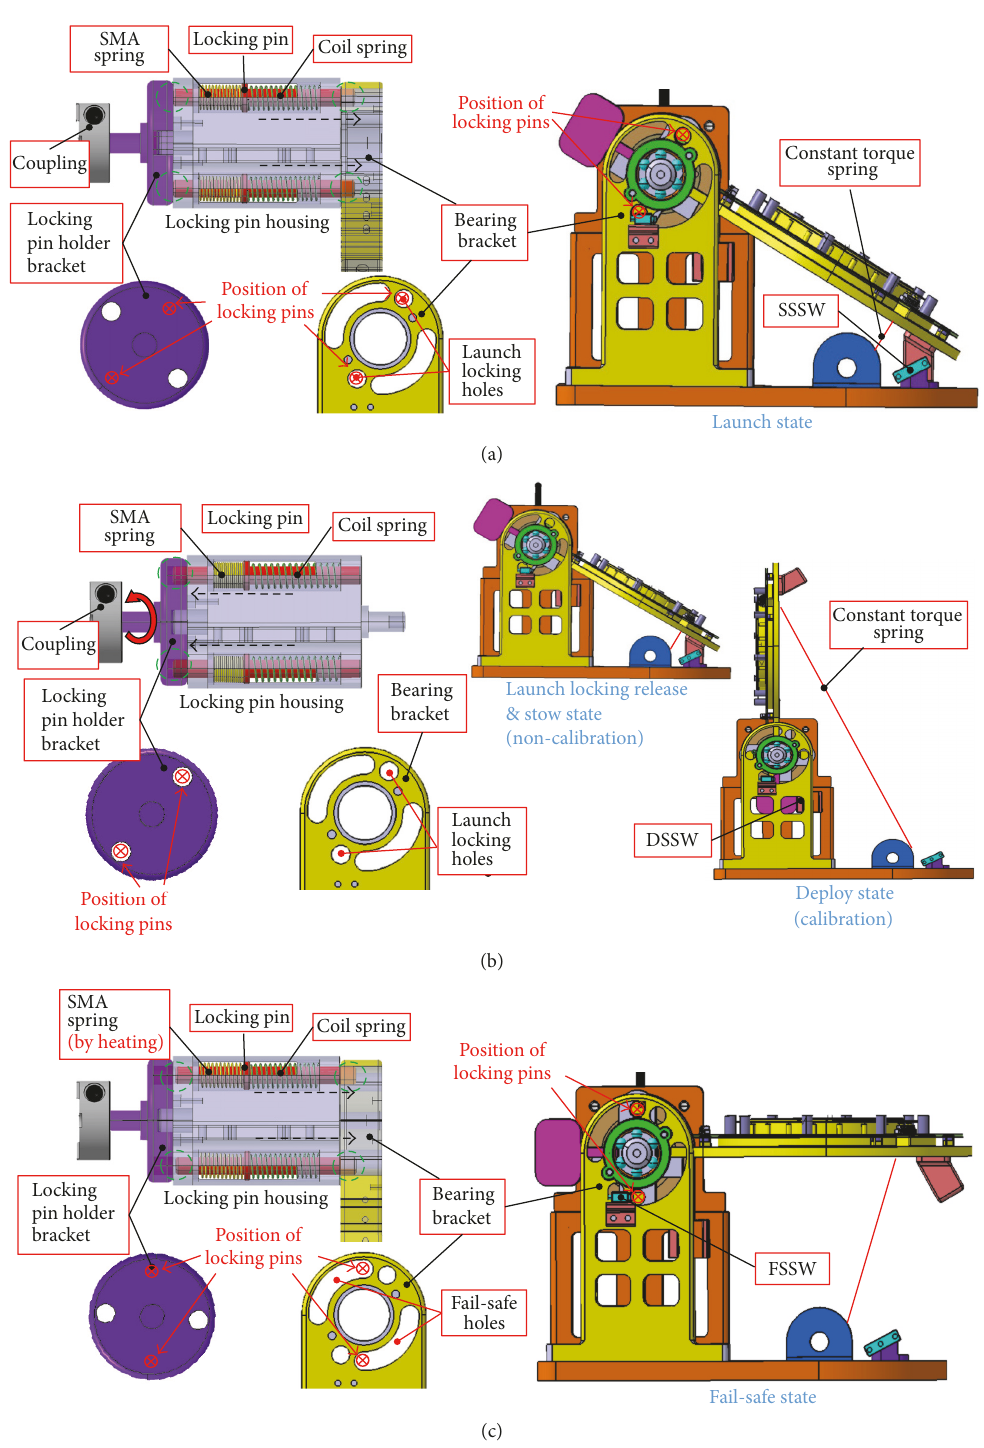
Figure 4: Operating principle of the tilting calibration mechanism for each operation phase ((a) launch phase, (b) launch locking release and on-board calibration phase, and (c) emergency